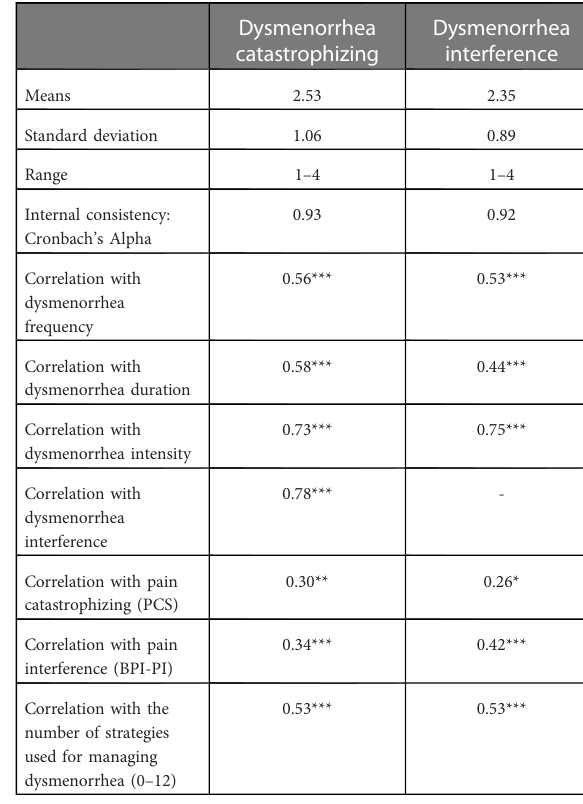
TABLE 3 Distributions, internal consistency and construct validity of dysmenorrhea catastrophizing and dysmenorrhea interference ( n =100) a .